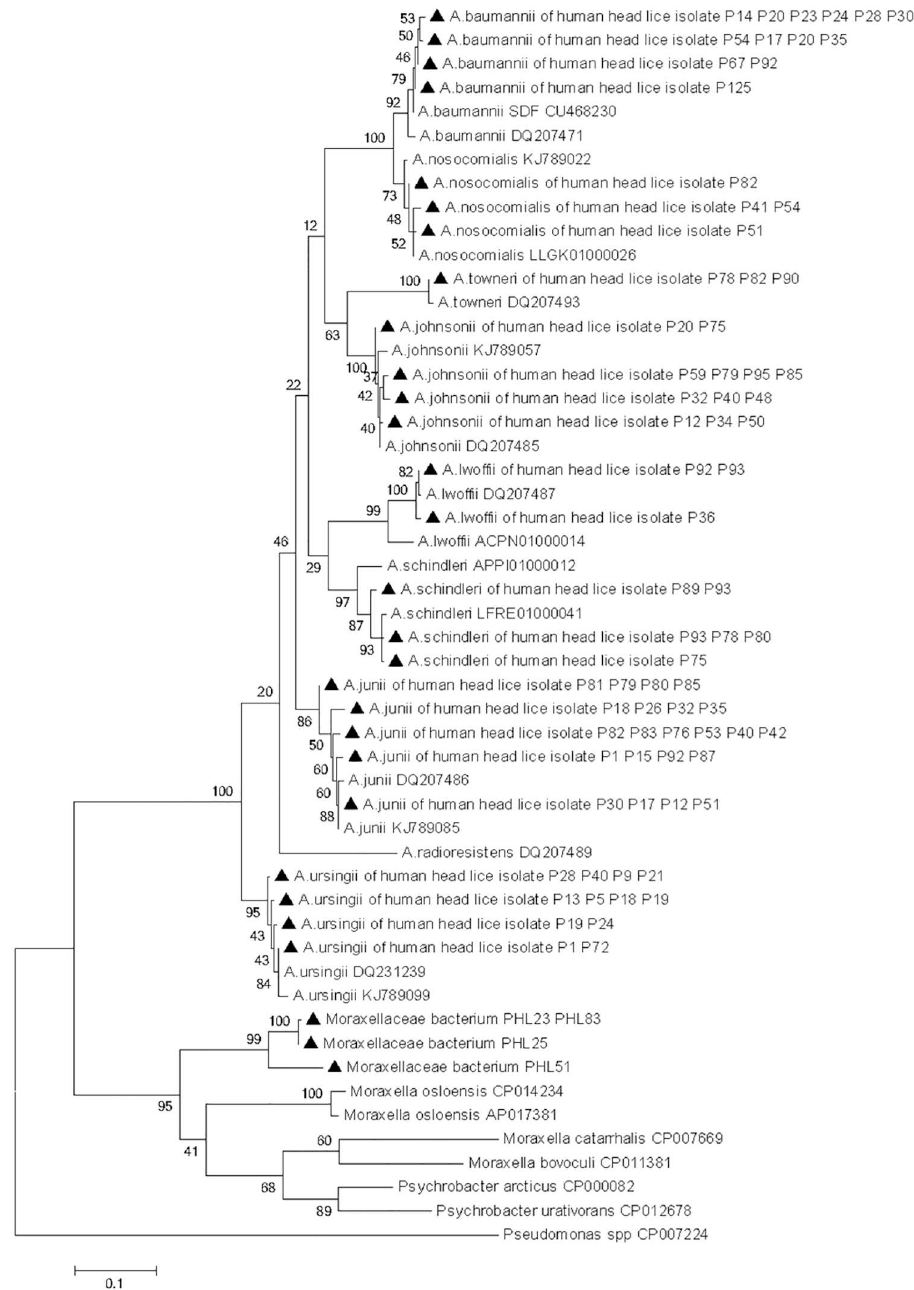
Fig 5. Maximum-likelihood phylogenetic tree based on 440-bp fragment rpoB gene of the Acinetobacter species and Moraxellaceae species, while Pseudomonas was used as an out group. B . recurrentis is the known causative agent of relapsing fever which, if untreated, can be fatal in up to 40% of patients [13, 43, 44]. It has long been established that body lice are the main vector for this bacterial pathogen [13, 27]. In the present study, the DNA of B . recurrentis was detected in 10/630 (1.58%) head lice belonging to clade A collected from 6/126 (4.76%) individuals. Specifically, all positives cases were only found in Pokola, suggesting that a small,